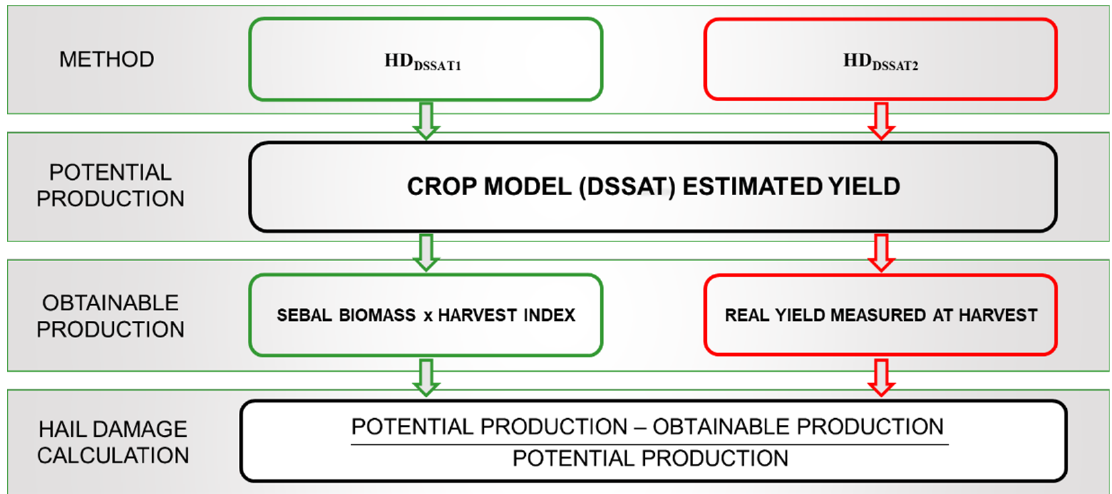
Figure 3. Overview of the calculation steps performed for the investigated DSSAT and SEBAL-based methods.